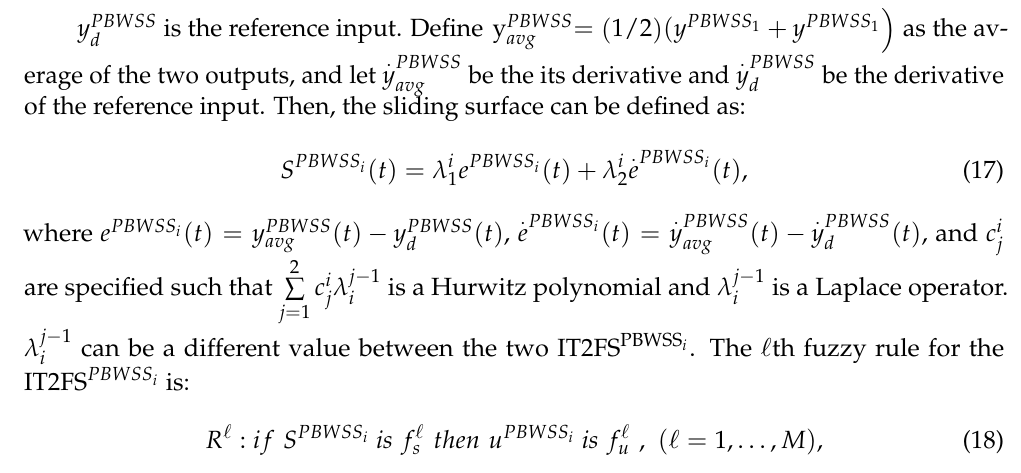
Figure 15. Block diagram of the IT2FSC for the PBWSS ( a ) the i th IT2FSC; ( b ) the overall control block for the